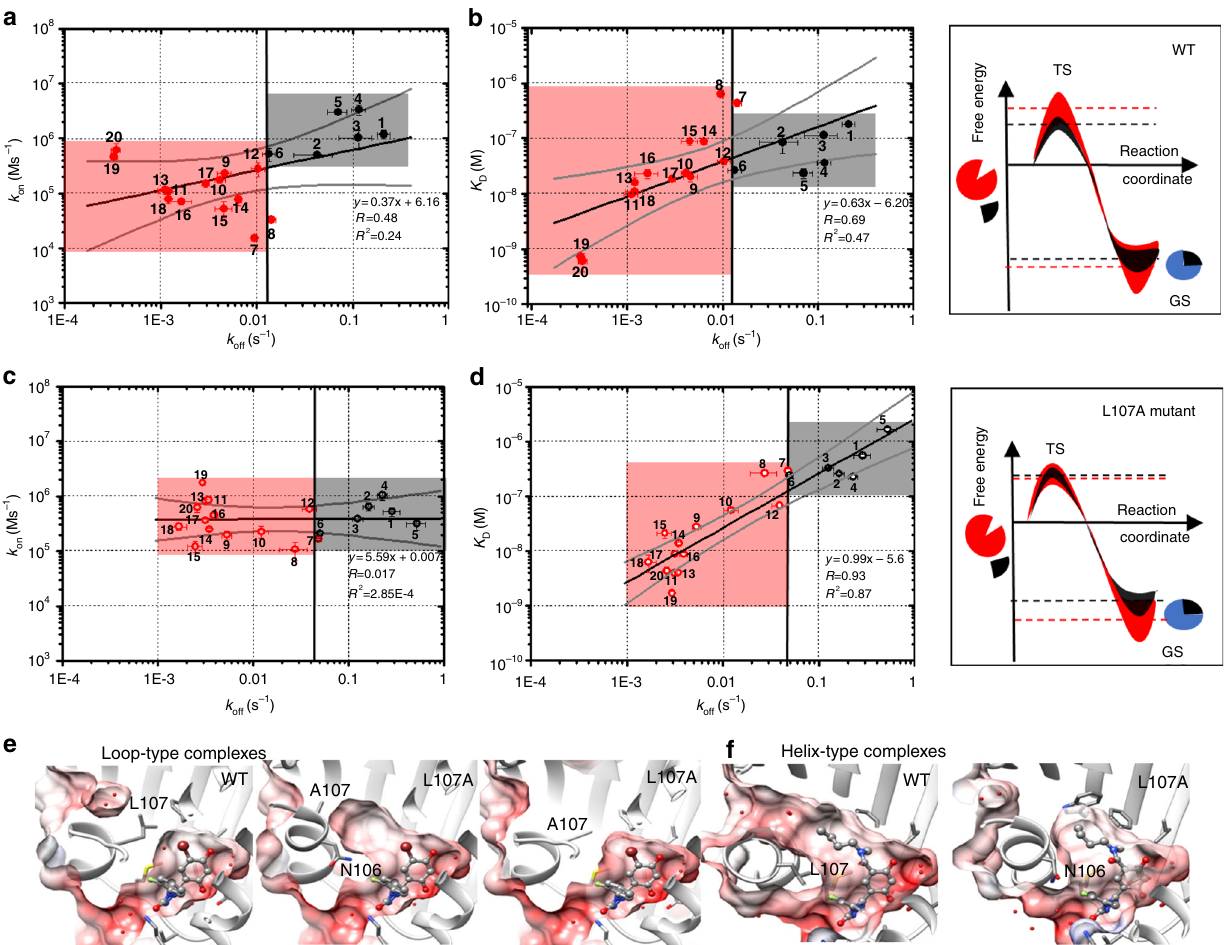
Fig. 6 Contributions of thermodynamic af fi nity and association kinetics to the modulation of dissociation rate constants. a - d Logarithmic plots showing correlation of dissociation rate constant k off ( x axis) with the association rate constant, k on , and the dissociation constant, K D , ( y axis) of compounds 1 – 20 determined by SPR for N-HSP90 WT ( a , b ) and L107A mutant ( c , d ). Points representing compounds assigned as loop-binders are colored black and compounds assigned as helix-binders are colored red. The black line is the linear regression with R 2 representing the coef fi cient of determination and R the correlation coef fi cient. The gray lines represent the 99% upper and lower con fi dence intervals. The error bars represent the standard deviation of at least three measurements. The red and black shaded regions highlight the different kinetic pro fi les of helix- and loop-binders, respectively. k off is not strongly correlated either with k on or with K D for N-HSP90 WT. Thus, an increase of residence time is driven by a combination of GS stabilization and TS destabilization. For the L107A mutant, k off is strongly correlated with K D ( R = 0.69 for WT and R = 0.93 for L107A) and not correlated with k on ( R = 0.48 for WT and R = 0.017 for L107A), indicating that residence time is mainly driven by GS stabilization. These relations are shown on the right in schematic pseudo 1-step free energy pro fi les for the binding reaction of helix- and loop-binders (shown in red and black, respectively; the fi lled area indicates the energy distribution among the entire compound series) Red and black dashed lines indicate average free energy values for the helix-and loop-binders, respectively. e , f The binding pocket shape observed in the crystal structures of N-HSP90 WT and L107A mutant for loop- and helical- complexes ( e , f , respectively). Two alternative conformations observed in the crystal structures are shown for the L107A mutant co-crystallized with compound 6 in e The molecular surface of the protein is colored from red to white indicating increasing